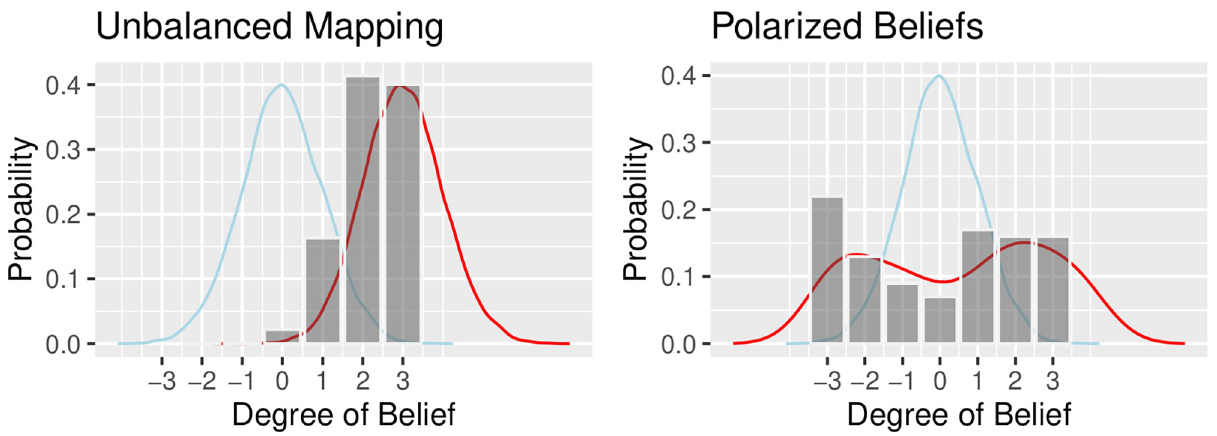
Fig 1. Likert maps: Survey assumptions (blue) Actual beliefs (red) Likert mapping (grey).